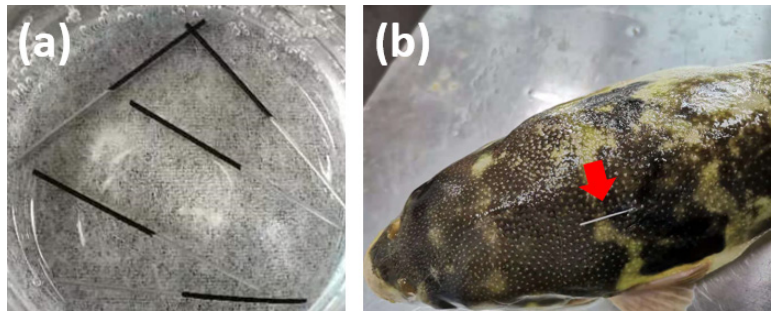
Figure 1. The GO-PAN@PNE fibers made via dipping method ( a ) and the in vivo sampling in the dorsal–epaxial muscle of living pufferfish using the SPME fiber ( b ).